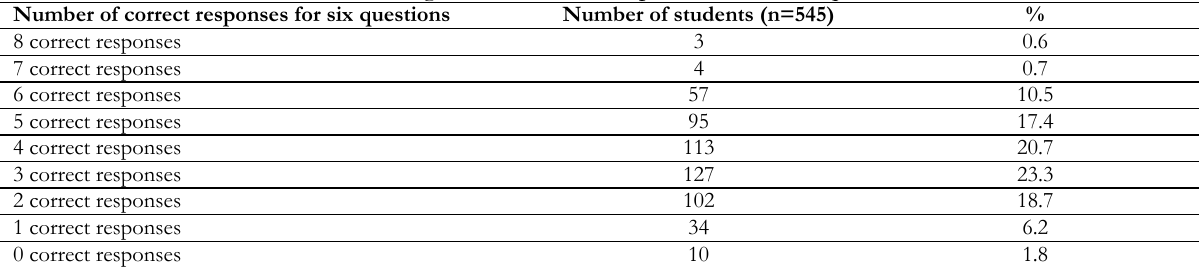
Table 4. Numbers of students recording various correct responses to the six questions Number of correct responses for six